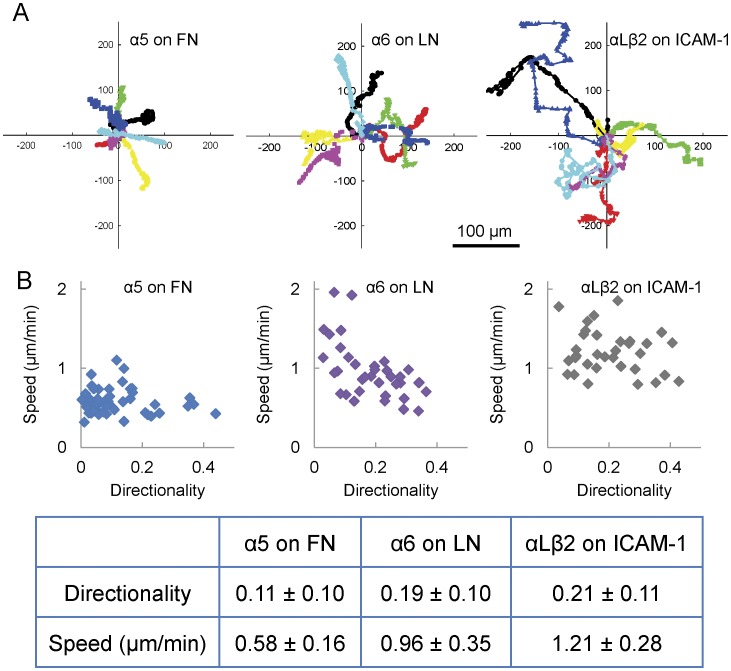
Migration of CHO.B2 cells expressing different integrins.(A) CHO.B2 cells expressing α5-GFP, α6-GFP, or αL-GFP + β2-GFP migrate randomly on fibronectin (FN), laminin (LN) or ICAM-1, respectively. Typical cell paths are shown, with each individual cell track assigned a different colored line translated to a common origin. Experimental time: 6 hours. Scale Bar  = 100 µm. (B) The speed and directionality, from at least three independent experiments, were calculated and plotted (cell number  = 52, 36, 33, respectively). The speed was calculated from the total length of a cell path divided by the experimental time. Cells on FN migrate about half as fast as cells on either LN or ICAM-1 (P<1×10−9), and the difference between cells on LN and ICAM-1 is small but still significant (P = 0.0017). Directionality was defined as the ratio of the length from the start to the end point and the length of the cell path.